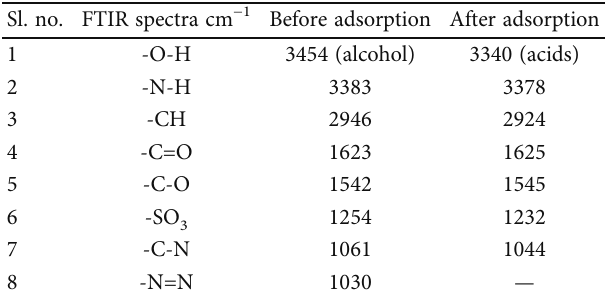
Table 2: FTIR band absorption frequencies of breadfruit leaf biochar adsorbent before and after adsorption of Congo red